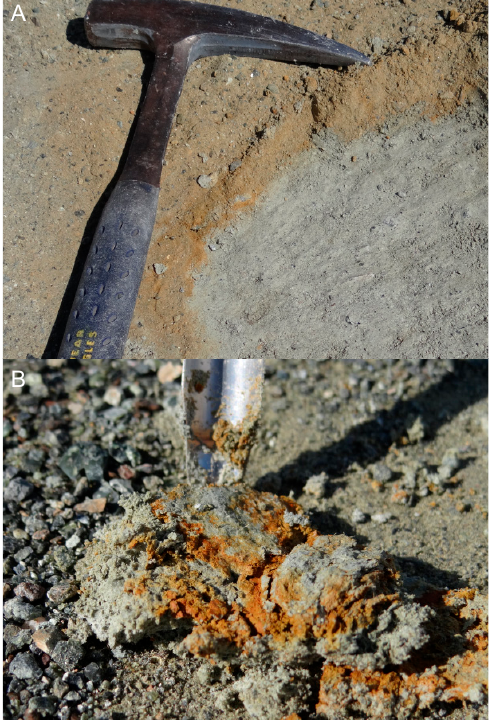
Figure 2. ( A ) After 11 weeks, a 2 mm-thick horizon of pyroaurite (orange material) formed at a depth of 2 cm in both plots. Below this horizon, a white layer of hydromagnesite was found from 2–4 cm depth (bottom right corner of photograph). ( B ) Intermixed pyroaurite (orange) and hydromagnesite (white) at the contact between the two horizons in the Bio-plot.